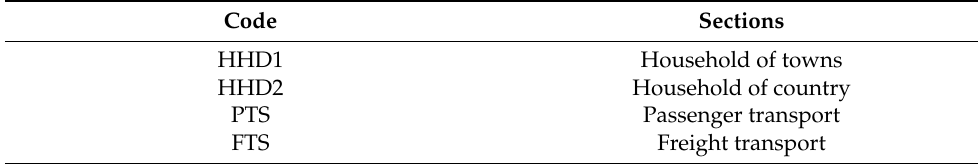
Table A2. Other sectors in the